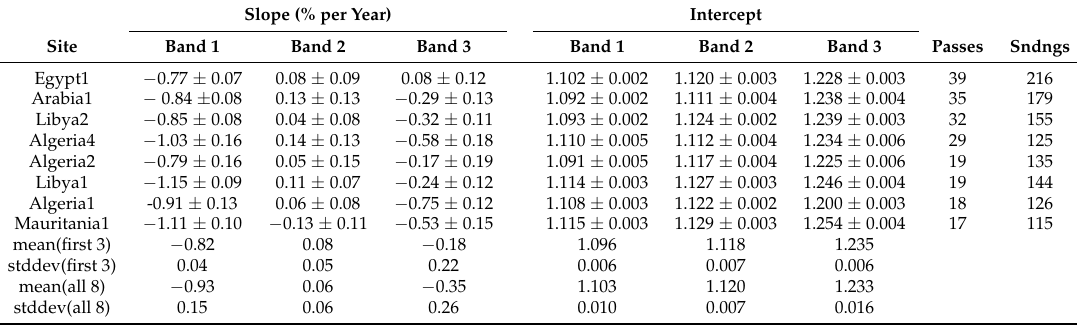
Figure 7. Correcting the aging of the solar calibrator: (red) model that incorrectly uses the exponential fit to the first eight points instead of the one to all twelve points; (green) correct model. Table 5. Summary of the slope and intercept for linear regression of OCO-2/MODIS radiance ratio. The second last column is the number of clear-sky OCO-2 passes over each site within the first five-year OCO-2 mission. The last column is the average number of clear soundings for each overpass. Slope (% per Year)